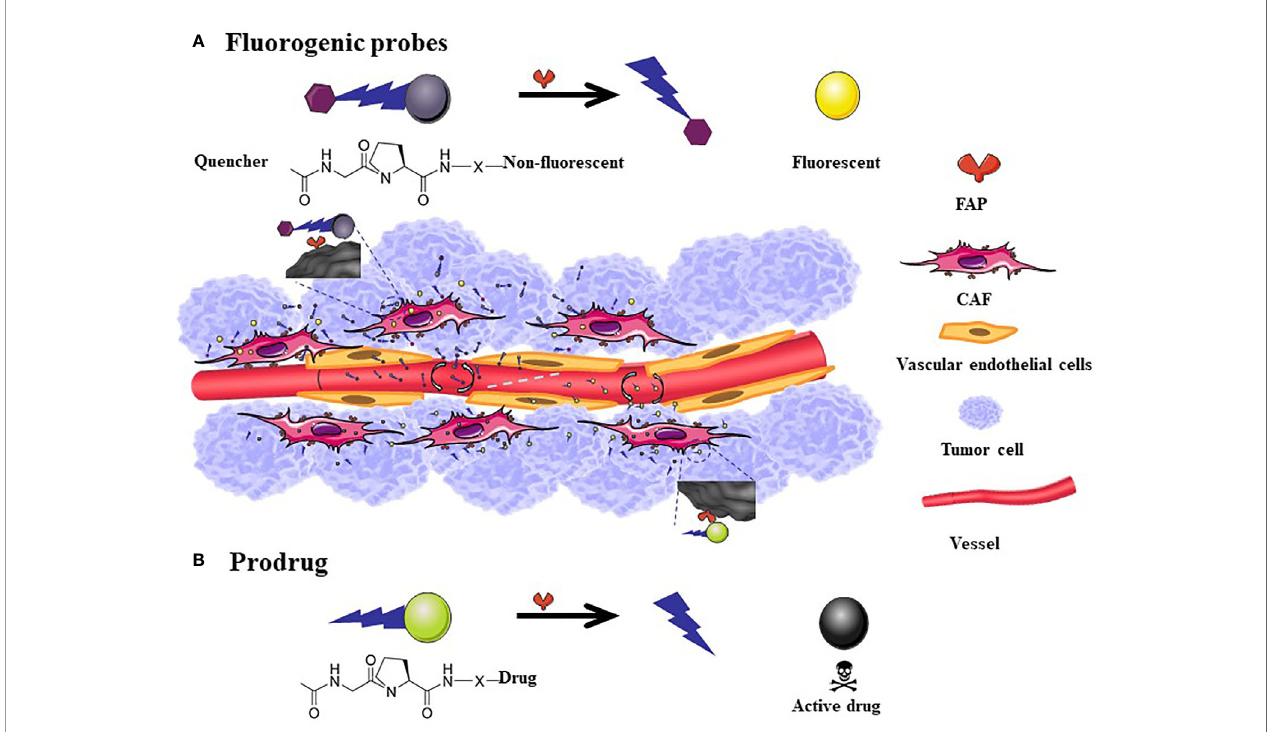
FIGURE 3 | The mechanism of action of fl uorogenic probe and prodrugs. The general scheme for Fluorogenic probes is that the quenched fl uorescence is restored after the FAP-speci fi c peptide is cleaved (A) . FAP targeted prodrugs: X indicates variable linkage between cleavable bond and drug in the C-terminal part of the prodrug. The toxicity of the drug reappears after the prodrug is cleaved (B) . The size of fl uorescent probes and prodrugs is much smaller than the nanometer level. Although it can easily penetrate into tumor tissues, a considerable amount of drugs will fl ow back into the blood vessels, therefore, there is no passive targeting